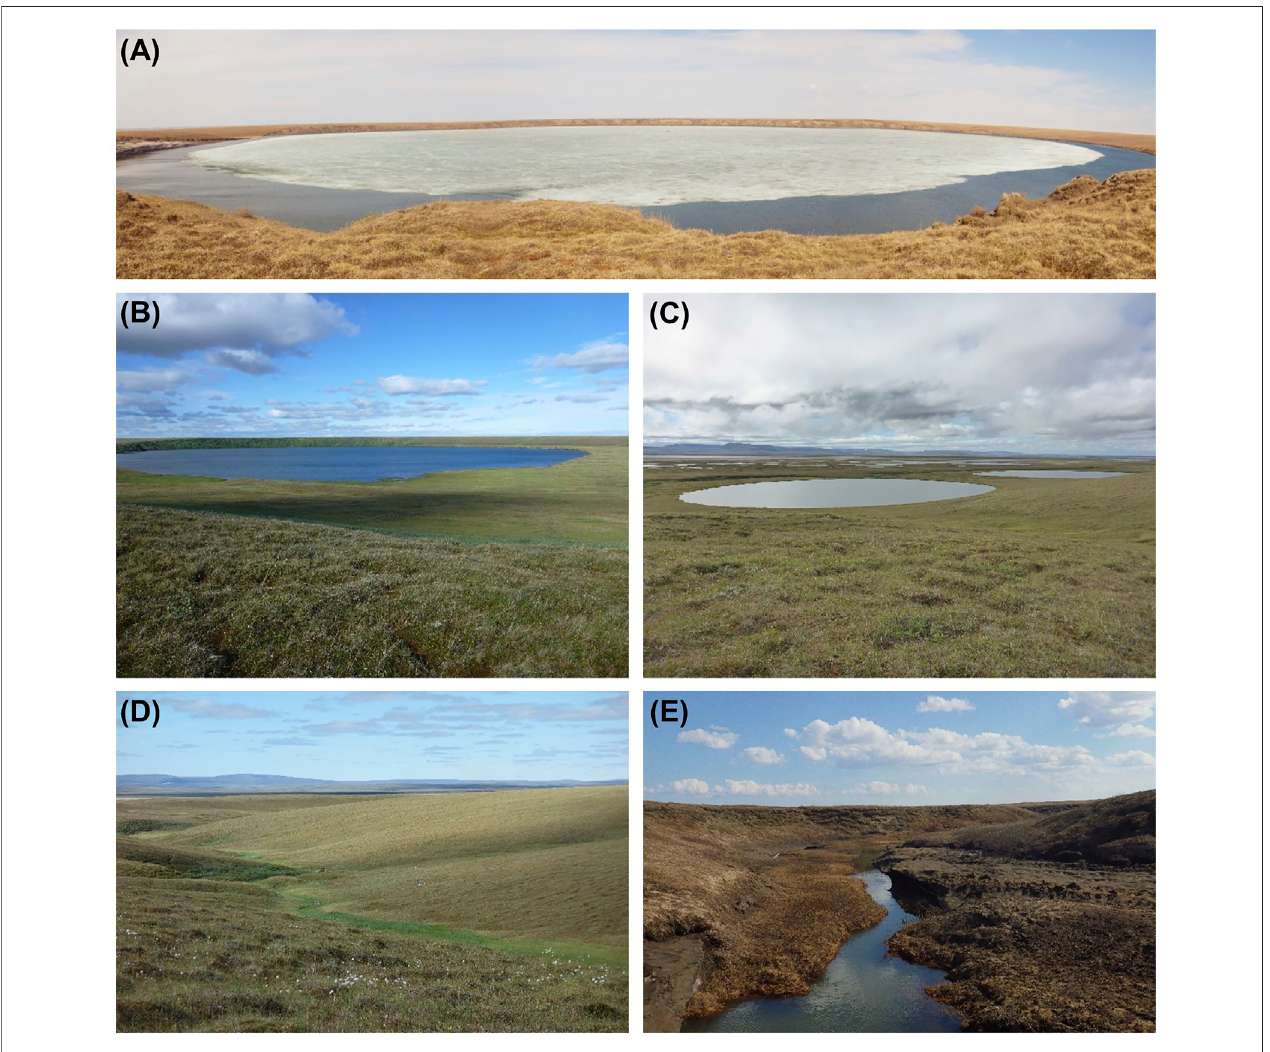
FIGURE 2 | Study site on Kurungnakh Island with (A) Lucky Lake (photo by Antje Eulenburg, June 2014), (B) Oval Lake in a drained lake basin (photo by Guido Grosse,July2016), (C) twosampledthermokarstlakesonthe1 st deltaunit(photobyJustine Ramage, July2016), (D) LuckyLake valleyincisedintotheyedomaupland on the 3 rd delta unit (photo by Anne Morgenstern, July 2016), and (E) Lucky Lake valley incised in the 1 st delta unit (photo by Antje Eulenburg, June 2014).